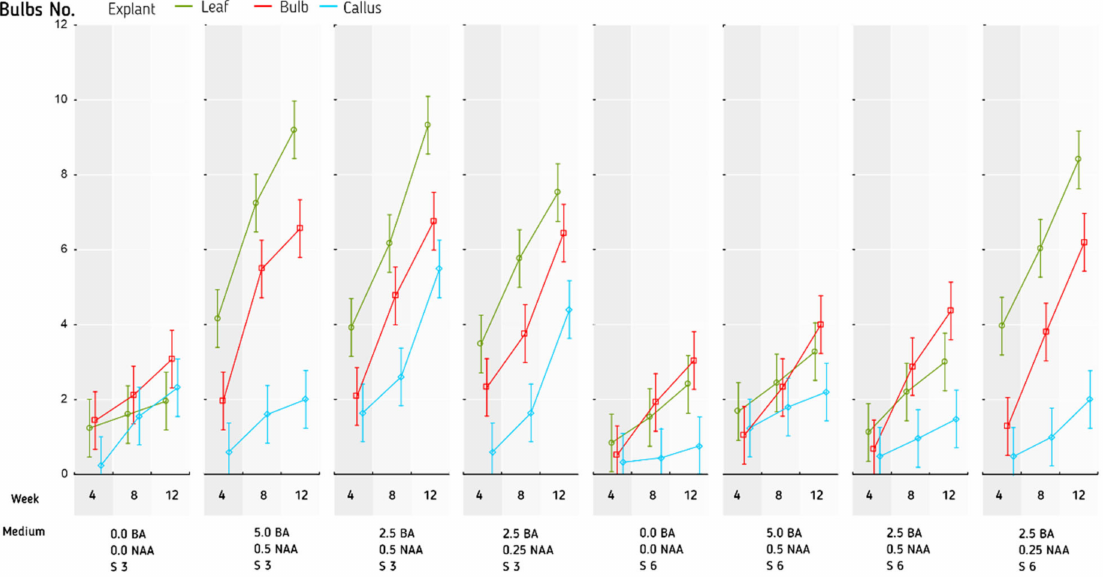
Figure 5. The dynamics of adventitious bulbs’ formation after 4, 8 and 12 weeks of cultivation, depending on the explant and medium type. The shown values are means ±